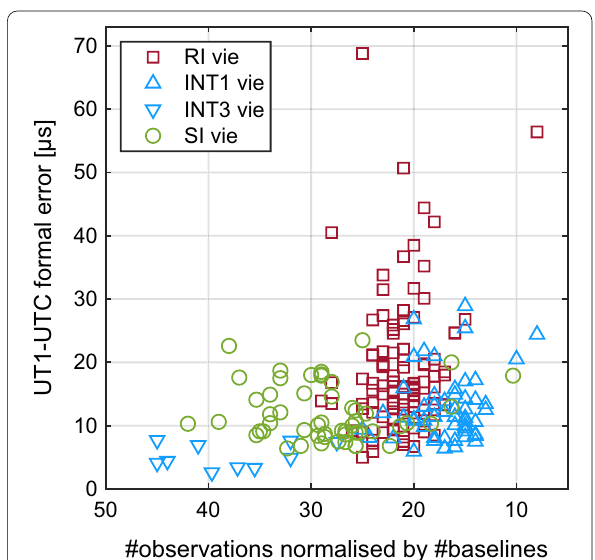
Fig. 5 Number of observations per session normalised by number of baselines versus UT1 UTC formal error −